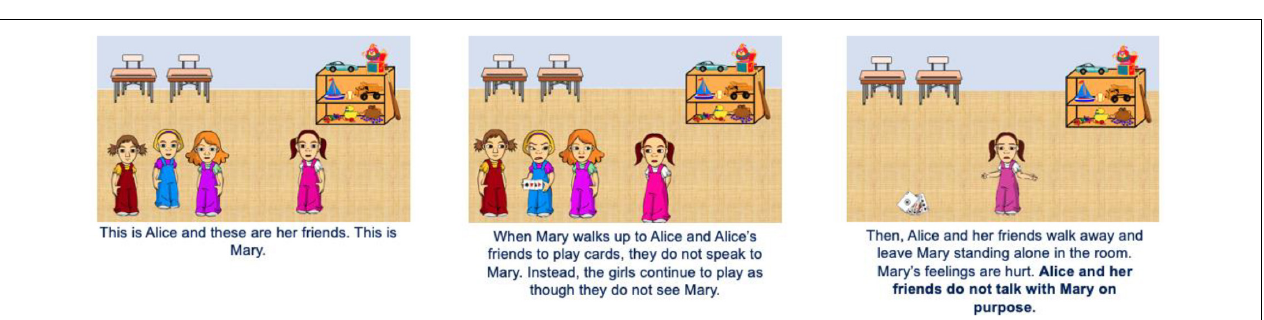
FIGURE 2 | Example story depicting relational aggression in the unambiguous condition. This story is depicted with girl characters.